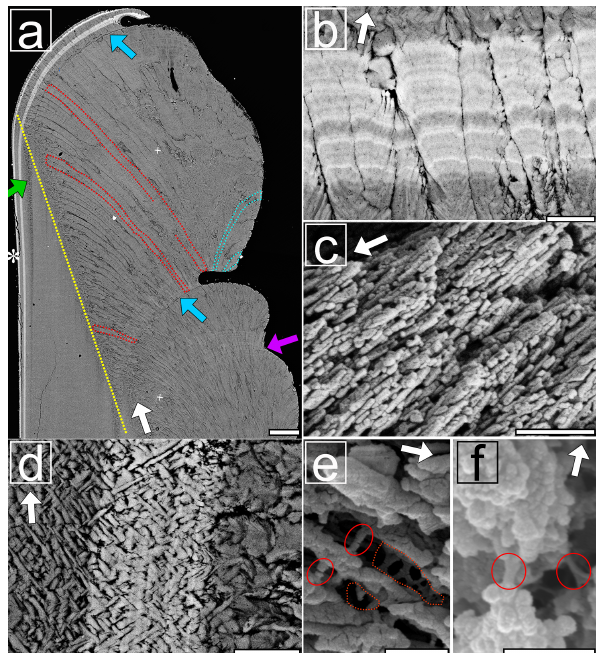
Figure 4. Electron images showing cross sections along the maxi- mum growth axis of Sr-labelled K. rhytiphora shells: (a) BSE image shows the ventral margin of the shell. First-order prisms in the pris- matic oOSL bend inwards (red outlined) and reach lengths of up to 700µm with widths of 17µm. Outward-bending prisms (blue out- lined) form the ridged surface ornamentation of the shell. Growth checks (blue arrows) are observed to occur directly at the end of ridge feature, but not all ridge features are concluded by growth checks (purple arrow). The dashed yellow line marks the bound- ary between iOSL and oOSL. Both Sr labels show bright greyscales and follow the growth front of the shell. In the iOSL, the growth check continues as a prismatic layer (green arrow). Strontium labels within the oOSL (b) show first-order prisms to consist of radially arranged second-order prisms, which in turn consist of third-order prisms with their long axis parallel to each other, as seen in a broken piece of shell ( c , SE image). The iOSL has a crossed-acicular ultra- structure ( d , BSE image) that is composed of needle-like lamellae intersecting at an angle of ca. 82 ◦ . Etched specimens ( e, f : SE im- ages) reveal the nano-granular texture of the mineral phase as well as organic compounds with fibre- (red circles) and sheet-like struc- tures (dashed red lines) in the prismatic (e) and crossed-acicular (f) layers. White arrows identify the general growth direction of the shell, while the Sr-labelled shell layers in BSE images visualizes the local growth directions for each ultrastructure. For more details see Figs. S3–S8. Scale bars: 100µm (a) , 5µm (b, d) , and 500nm (c, e, f)